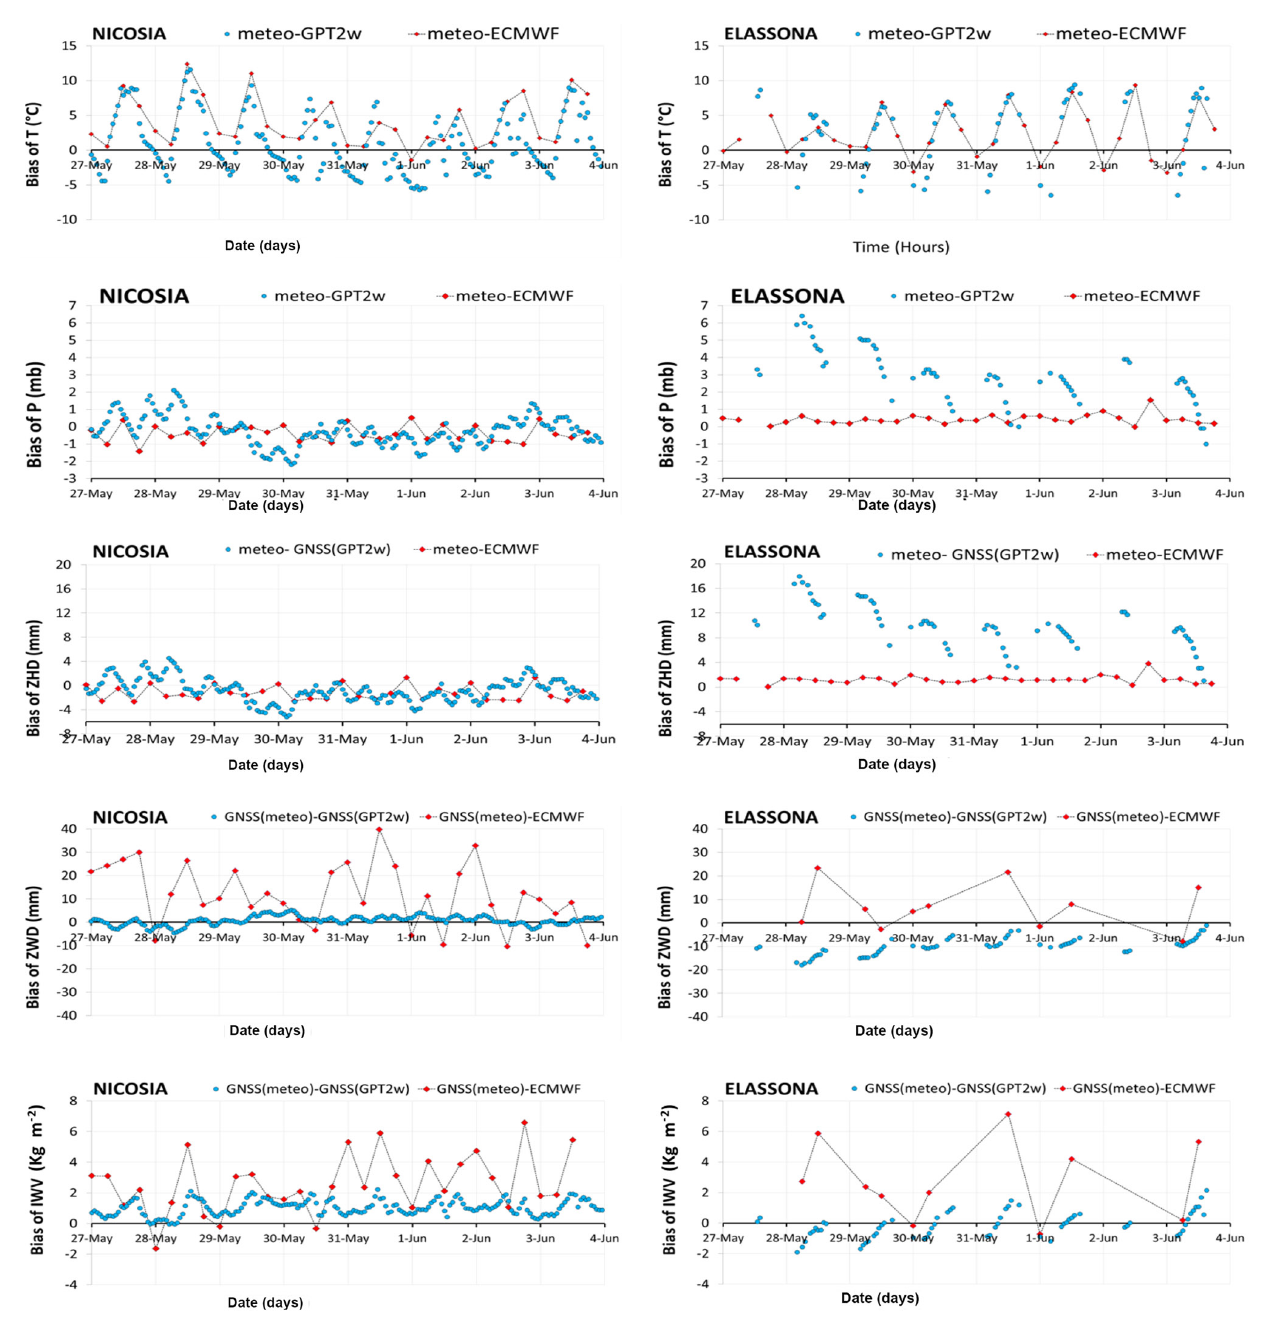
Figure 3. Bias between in situ T , P observations and T , P values from GPT2w (blue dot) and ECMWF models (red box). Also, bias between ZHD, ZWD, and IWV values retrieved from GNSS observations by using T , P from collocated meteorological stations and the respective ZHD, ZWD, IWV values retrieved from GNSS observations by using T , P from GPT2w model (blue dots), the respective ZHD, ZWD, IWV values retrieved from ECMWF model (red boxes) for Nicosia and Elassona stations during 27 May–3 June